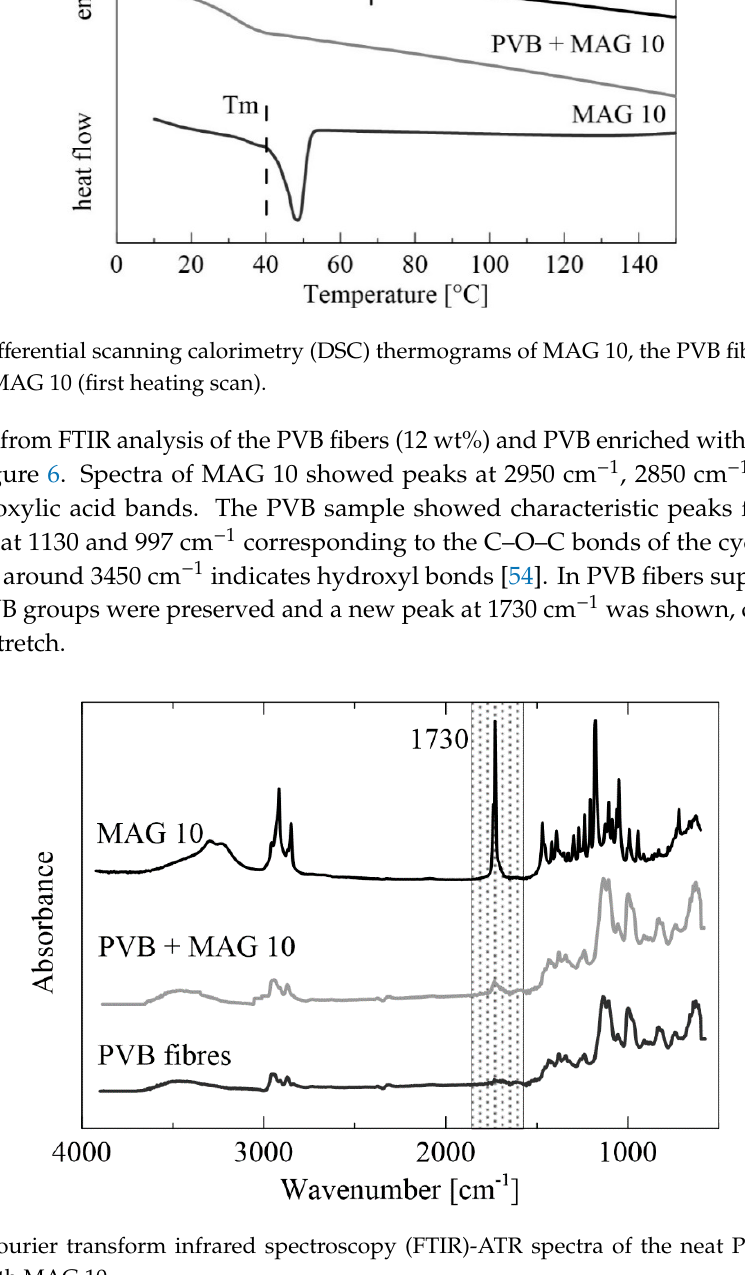
Figure 4. Fiber diameter vs. concentration of MAG 10. The various letters indicate significant differences ( p < 0.05) between the samples.